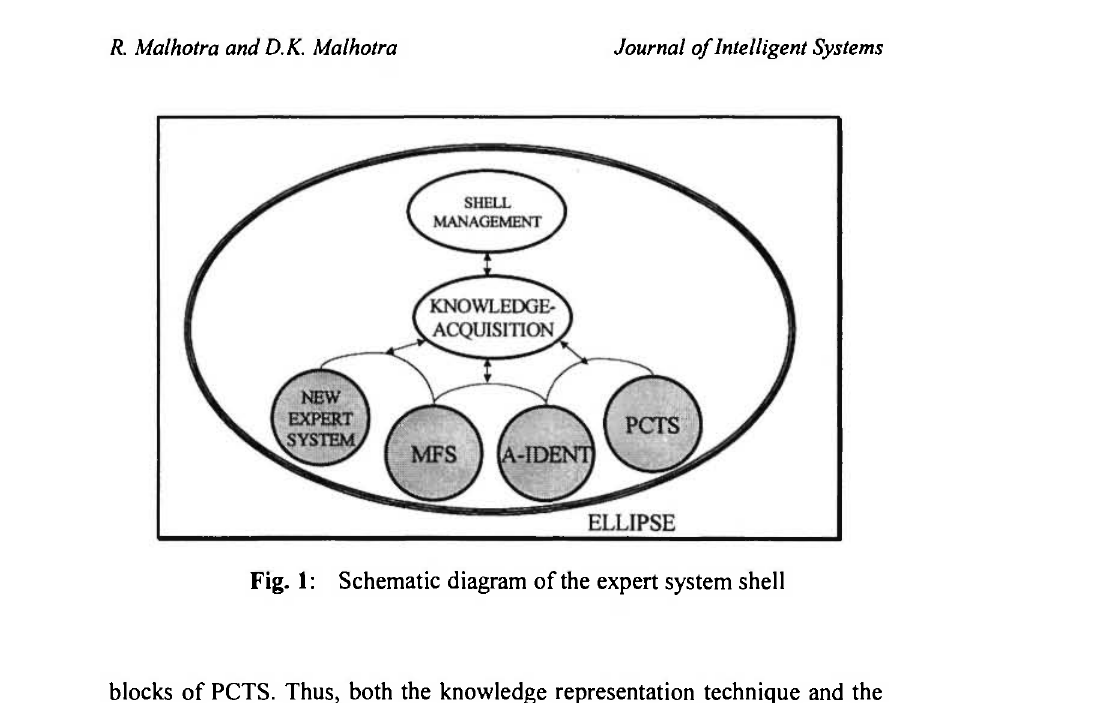
Fig. 1 : Schematic diagram of the expert system